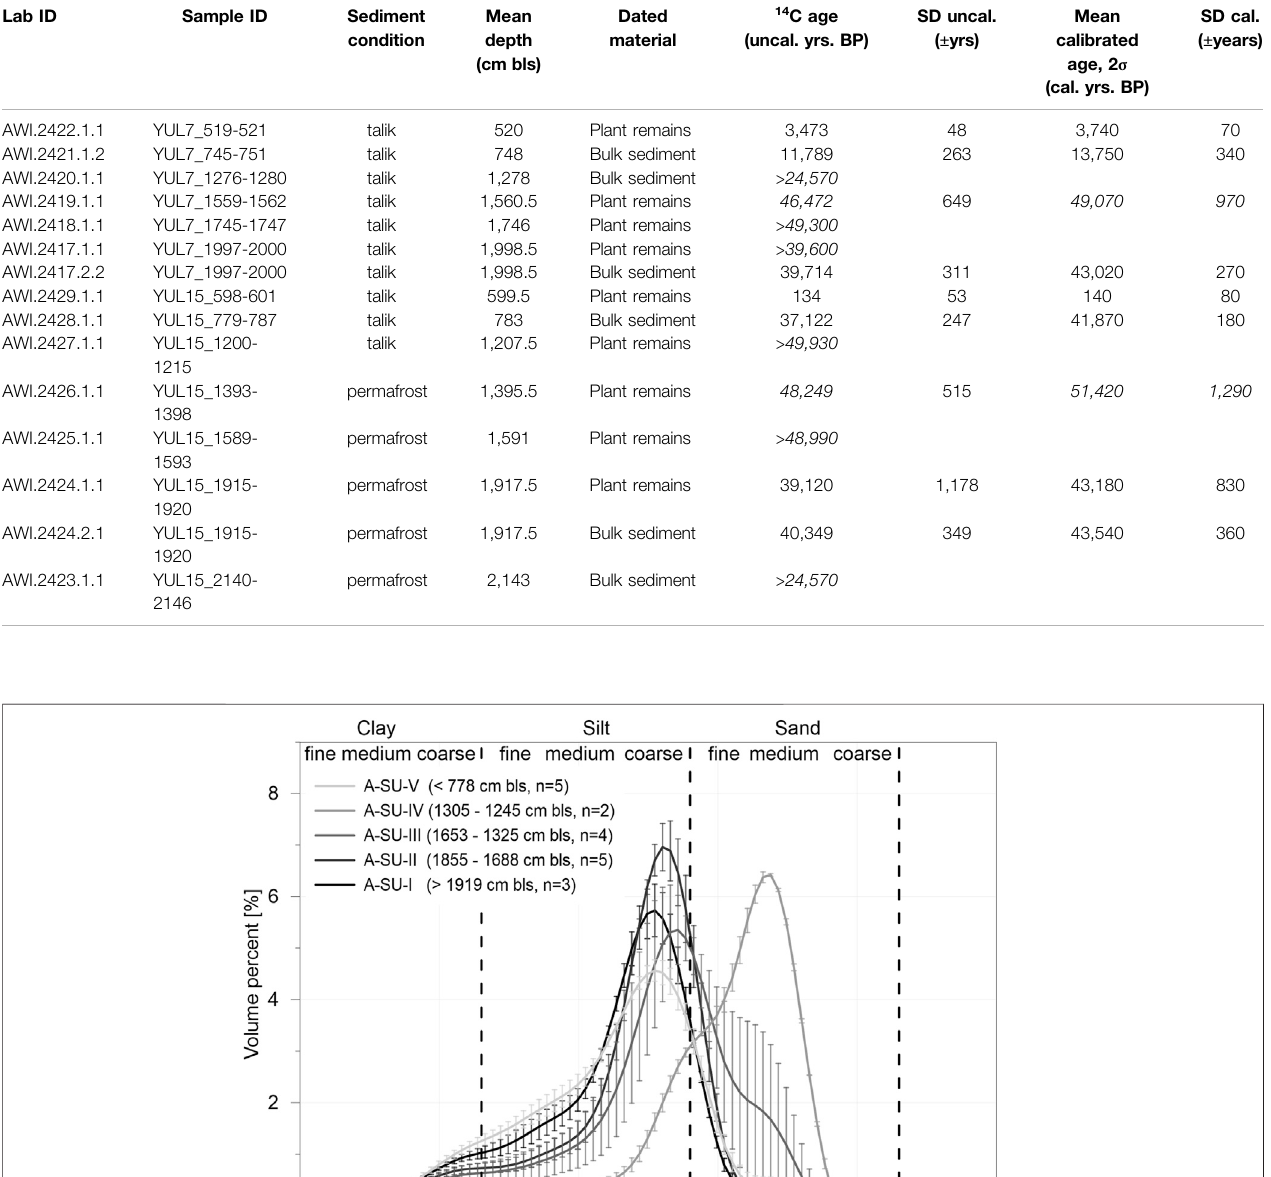
TABLE1| RadiocarbondatingresultsforthealaslakecoreYU-L7andtheYedomalakecoreYU-L15.Themeancalibratedagesareroundedto10 years.In fi niteandinverse ages are highlighted in italics.